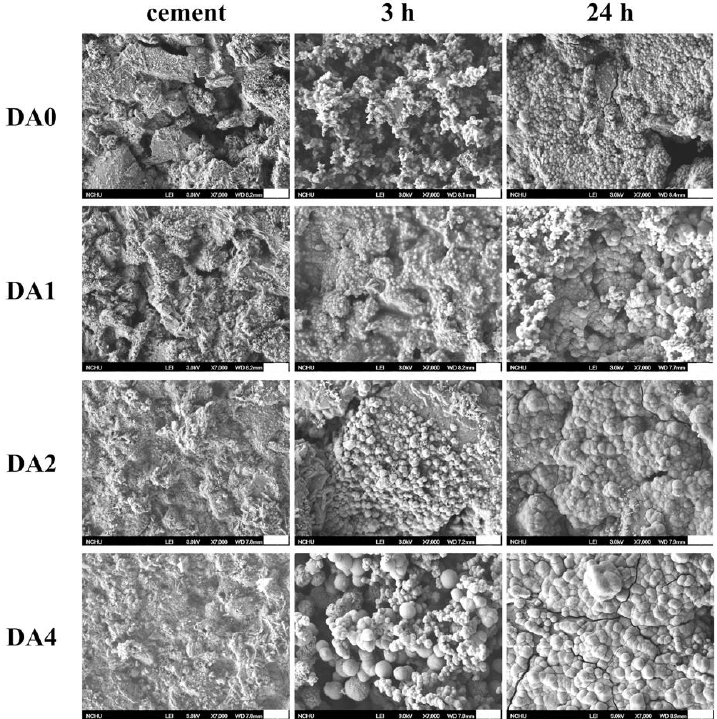
Figure 4. SEM micrographs of different PDA-coated CS cements before and after soaking in DMEM. The scale bar is 2 µ m.